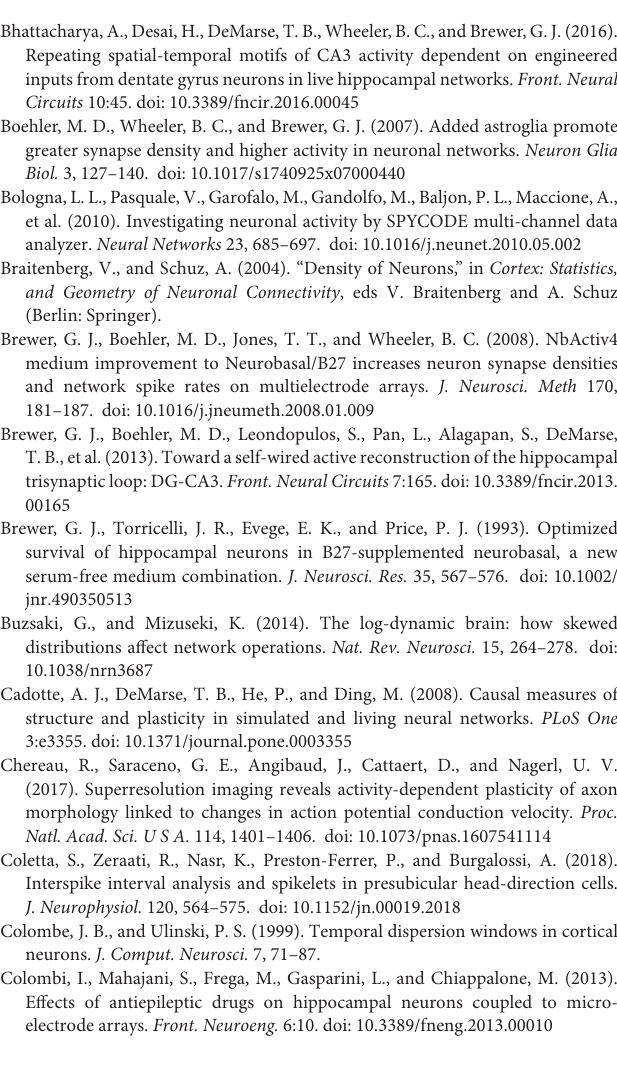
0.63 ms, which corresponds to an axonal conduction velocity of 0.32 m/s, from the CA3 to the CA1 side. (G) Another primary axon with spikes traveling backward from CA1 to CA3, with a delay centered at − 0.54 ms for a conduction velocity of − 0.37 m/s. Supplementary Figure 2 | Raster plots of spontaneous spikes from the 10 MEAs used for this study. Each line is 30 s. Twelve lines at each electrode equals 5 min of recording (heavy boxes are the tunnels). Supplementary Figure 3 | Measured features of spike trains include burst properties of interspike intervals, spikes per burst, inter-burst intervals, intra-burst spike rate, and burst duration. Supplementary Figure 4 | Fractions of total spikes occurring inside bursts ( n = 10 arrays). About 60% of spikes were inside bursts with no significant differences by analysis of variance (ANOVA). The largest difference between feed-forward and feedback axons between EC and DG did not reach significance at p = 0.09 [ F (1, 15) = 3.3] ( n = 10 arrays). Supplementary Figure 5 | Poor correlation of feed-forward axons from CA3 is not due to low activity in CA3. (A) Strong activity in CA3 source is poorly correlated with (B) corresponding time range in axons emanating from CA3 toward CA1. Ten electrodes in CA3 are shown in A. Red dots mark